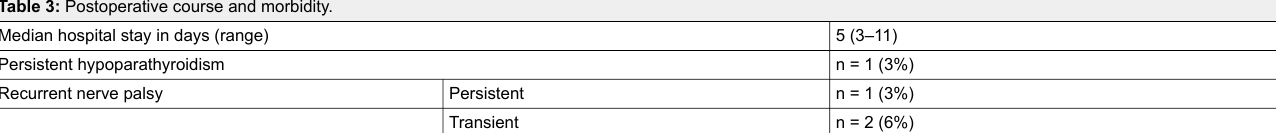
Table 3: Postoperative course and morbidity. Median hospital stay in days